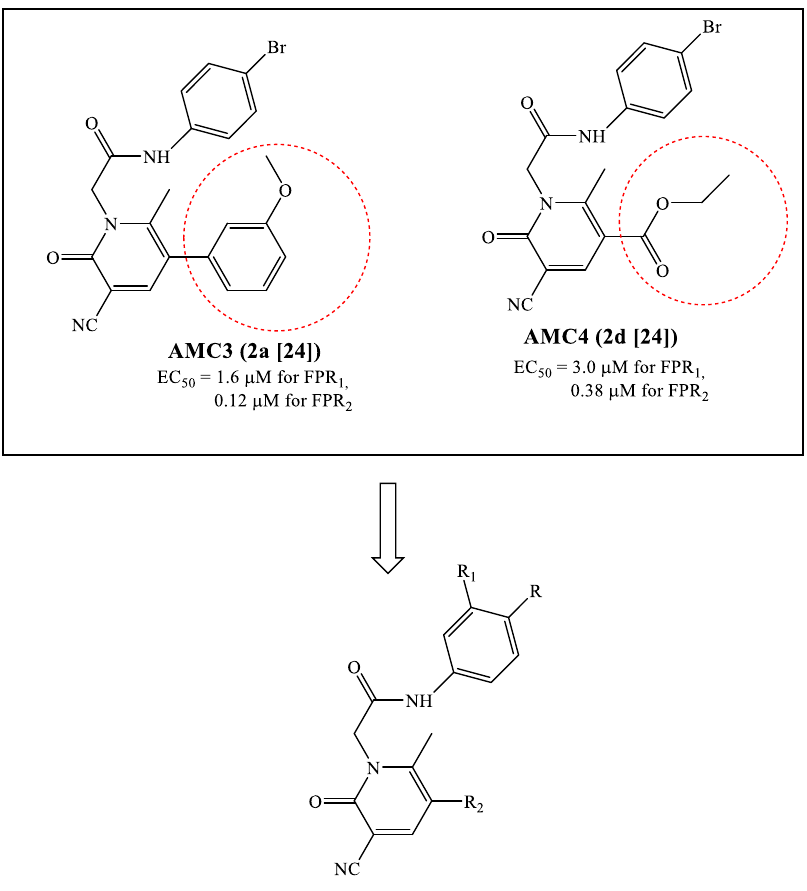
Figure 2. Structures of FPR agonists AMC3 and AMC4 and new potential FPRs agonists with pyridinone scaffold.